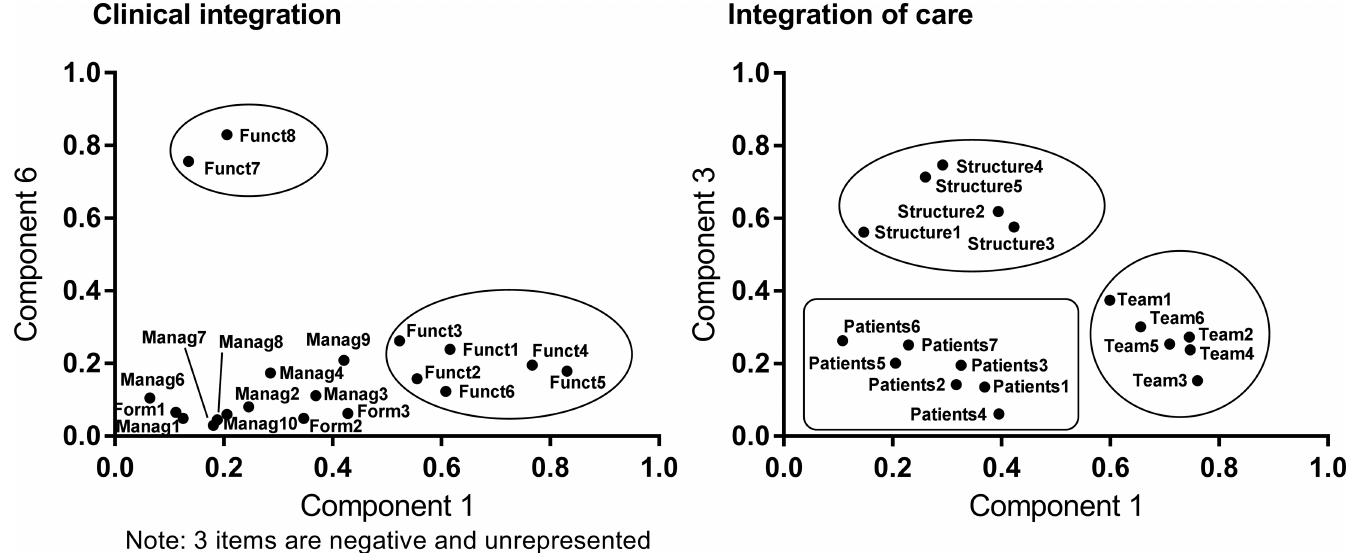
Fig 3. Graphical representation of principal component analysis for new sub-dimensions of clinical integration and integration of care.